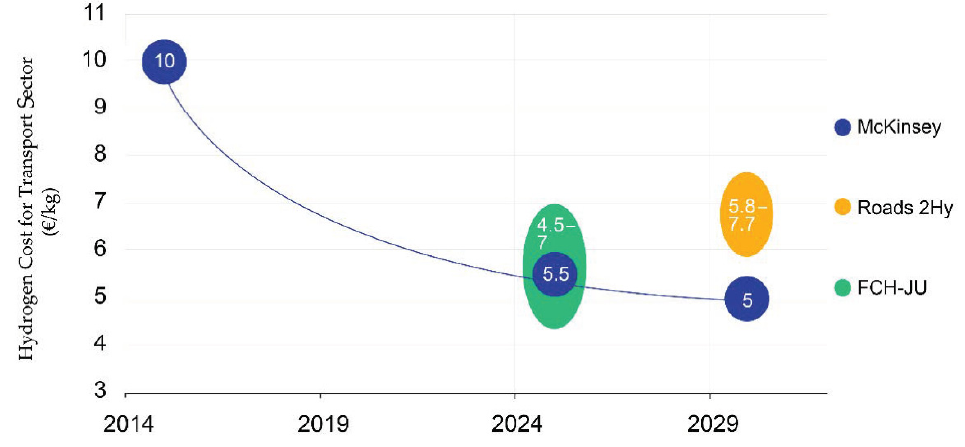
Figure 1. Hydrogen cost development from 2015 to 2030.